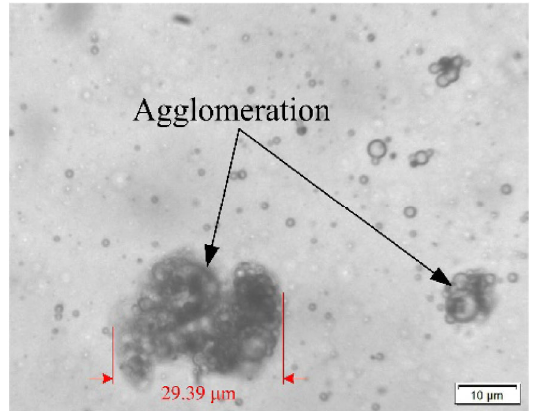
Fig. 15 Micrograph of droplet size distribution in WOS-G (0.5 wt.%) cutting